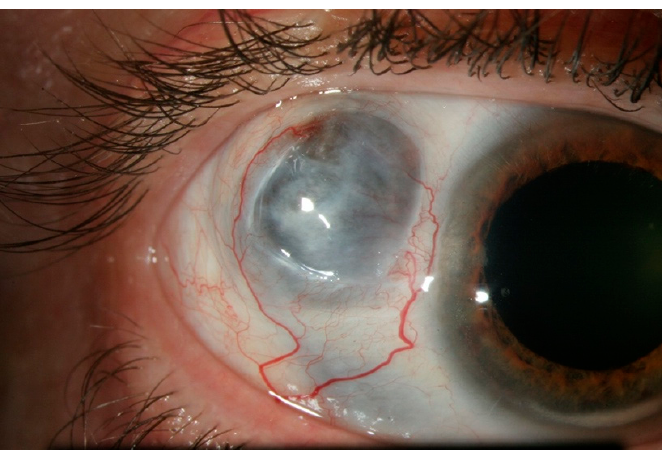
Figure 5. Necrotizing scleritis with inflammation. This form presents like a diffuse scleritis with an area of avascular, necrotic sclera.